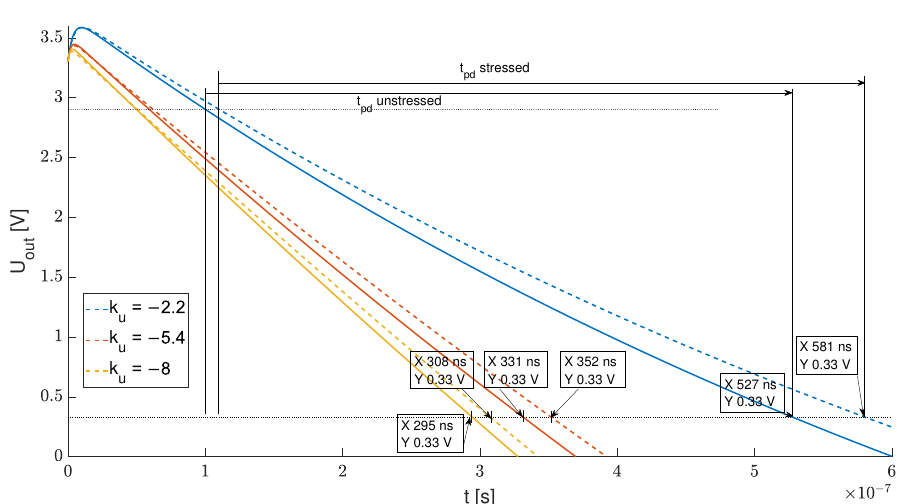
Figure 10. Example step responses and the influence of k u on t pd for stressed and unstressed devices.